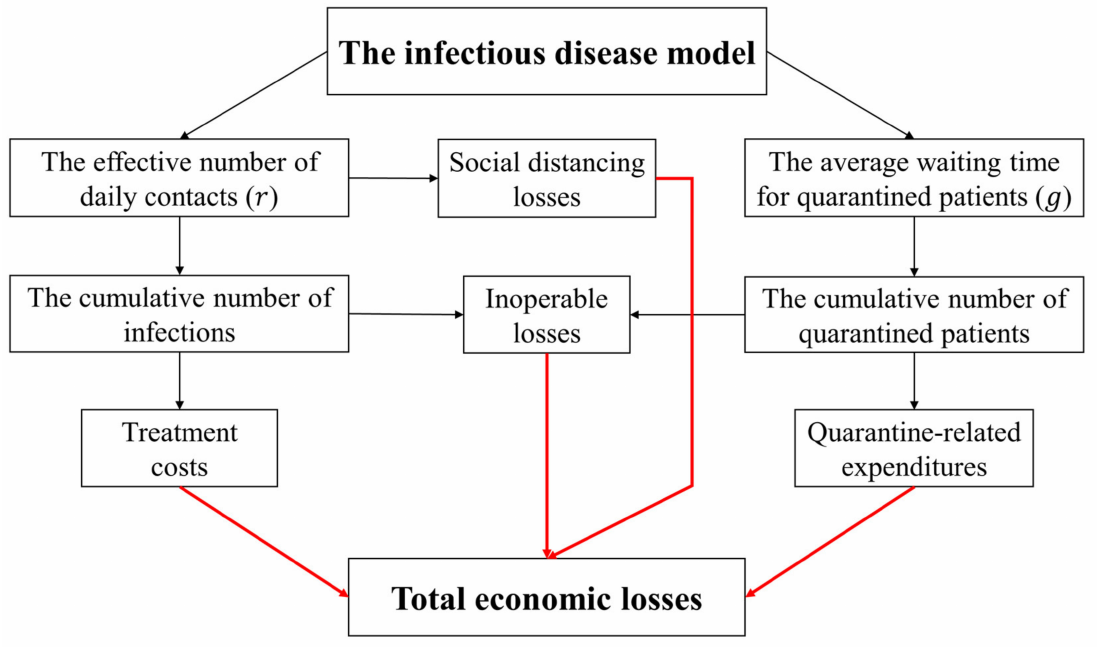
Figure 2. The framework of estimating total economic losses under various control